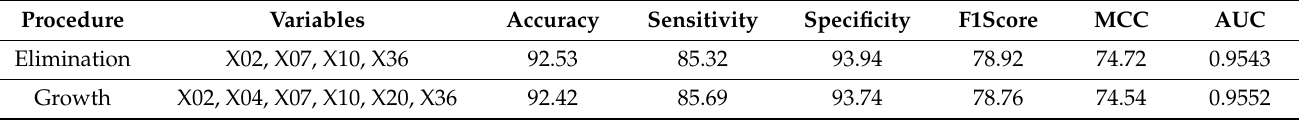
Table 6. The results based on elimination and growth